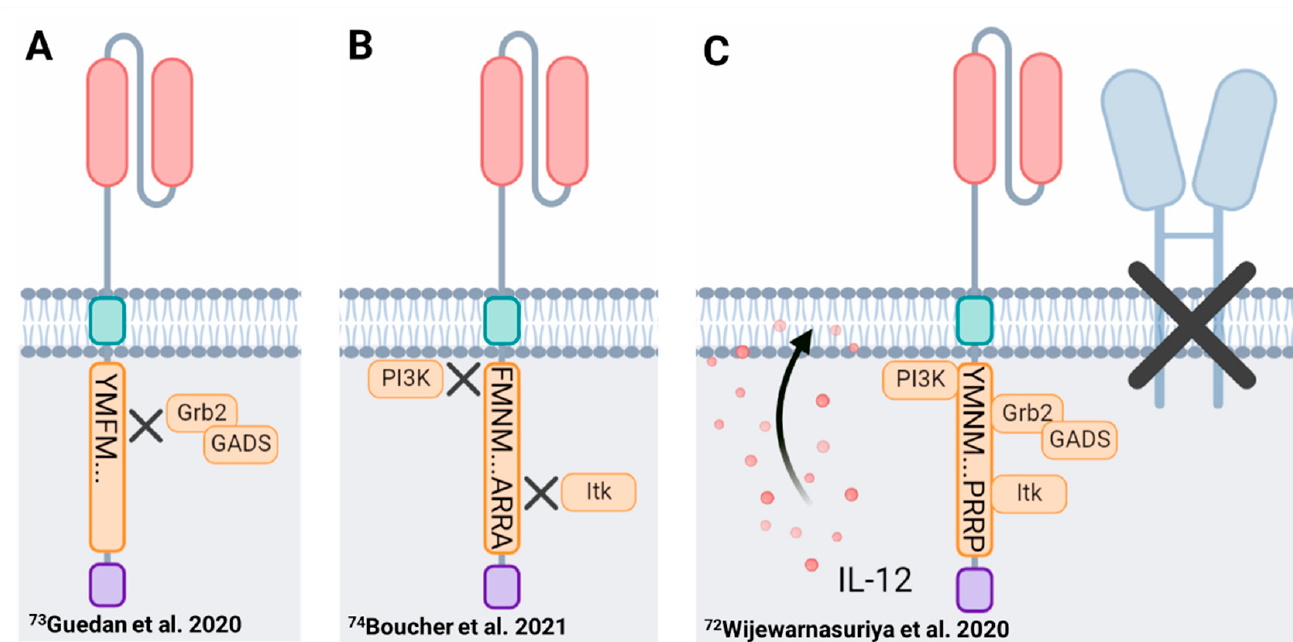
Figure 3. Targeting CD28 to optimize co-stimulatory signals. A, B. Site-directed mutagenesis of amino acid residues in the CD28 domain abrogate binding of adaptor signaling molecules. C. Ge- netic deletion of the endogenous CD28 receptor eliminates additional co-stimulatory signals deliv- ered to CAR-T cells in vivo. Reductions in CD28-mediated activation signals preserve stem memory/central memory phenotypes, reduce expression and chromatin accessibility of exhaustion- associated genes and promote enhanced CAR-T cell persistence in preclinical models.